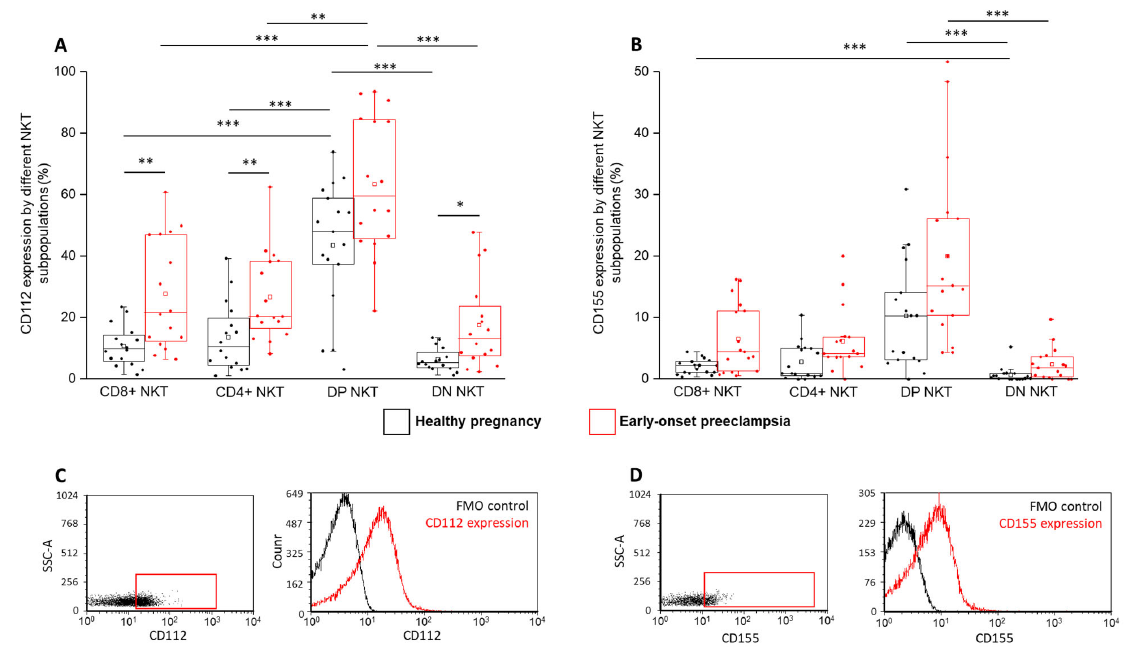
Figure 6. CD112 and CD155 ligand expression by different NKT cell subpopulations in EOP and healthy pregnancy. CD112 ( A ) and CD155 ligand expression ( B ) by the CD8 and CD4 surface molecule positive and negative NKT cell subpopulations in EOP patients and healthy pregnant women. The solid bars represent medians of 16, 16, 17 and 17 determinations, respectively. The boxes indicate the interquartile ranges, and the whiskers show the most extreme observations. The middle square within the box represents the mean value. Significant differences with p ‐ values < 0.01 ***, <0.03 ** and <0.05 * are indicated. Representative FACS plots show the CD112 surface marker ( C ) and CD155 surface molecule ( D ) expression by cells in the lymphocyte gate. FMO control was used to determine CD112 and CD155 expression.